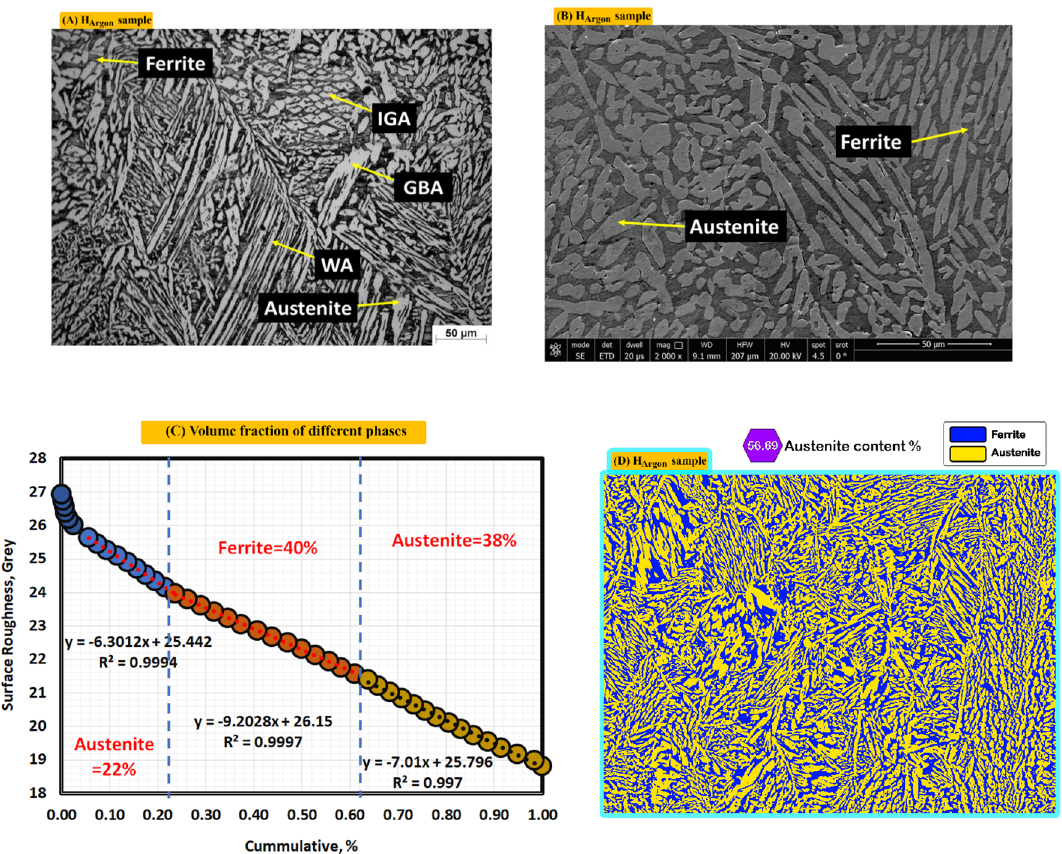
Figure 8. Optical and SEM micrographs of weld zones of sample (H Argon ) protected with Argon gas during PWHT process ( A ) optical microstructure, ( B ) SEM photo, ( C ) volume fraction by MATLAB software, and ( D ) austenite content of one random image of weld zone by image J